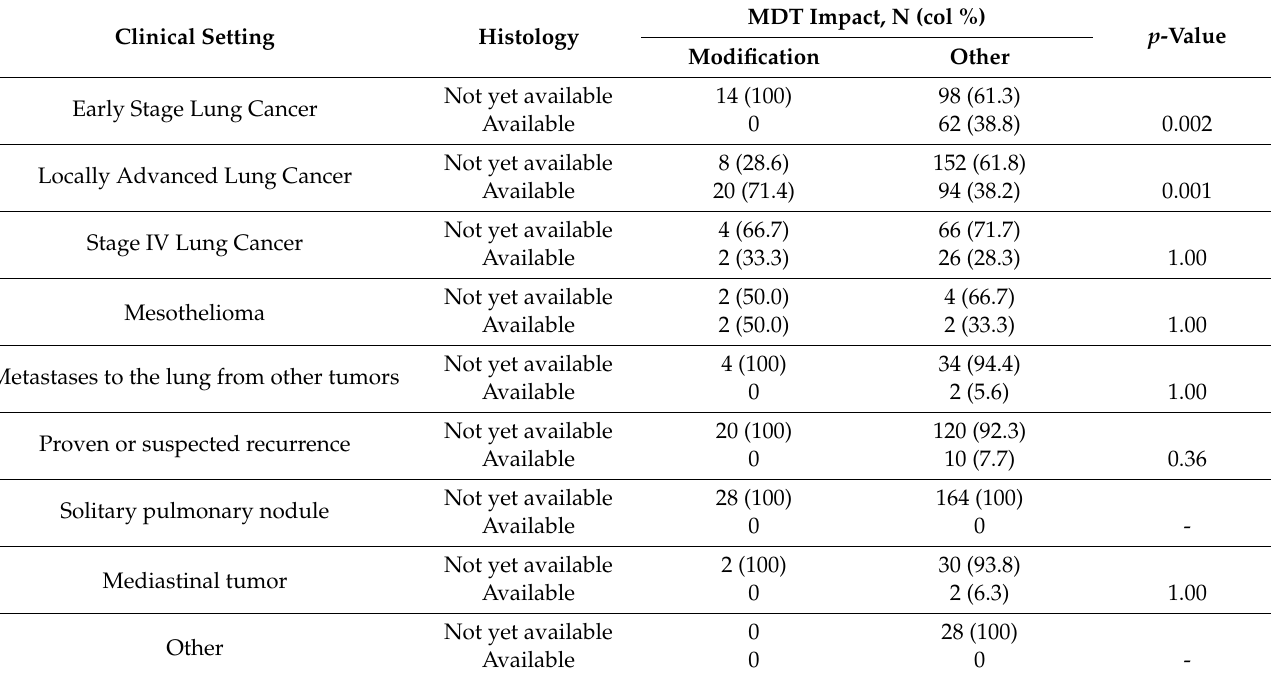
Table 3. Frequency distribution of the availability of histology at out-patient evaluation according to the clinical setting.